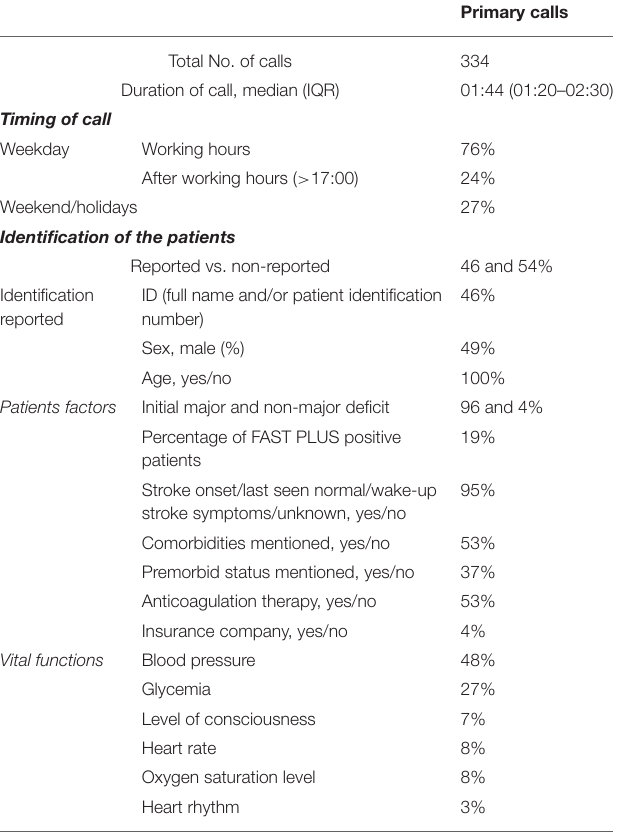
TABLE 1 | Teleconsultation content